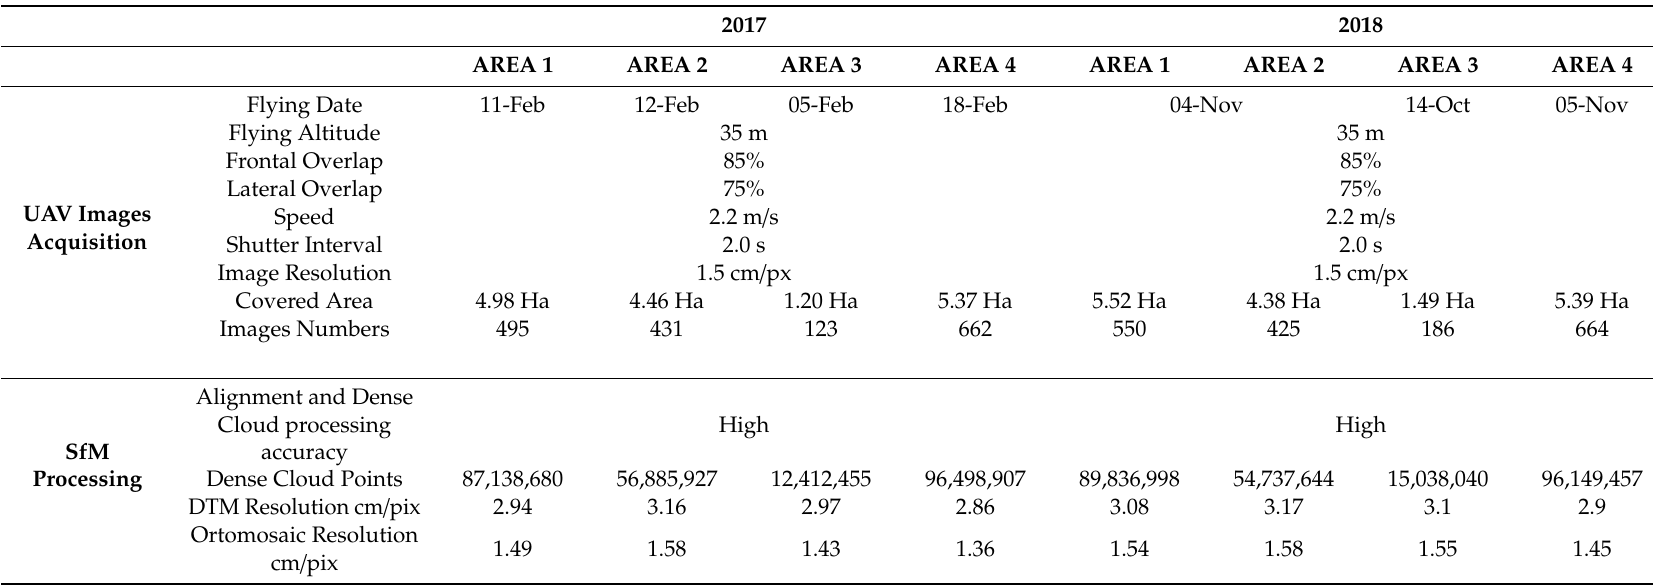
Table 1. UAV survey periods and flight acquisition parameters and SfM processing specifications for selected